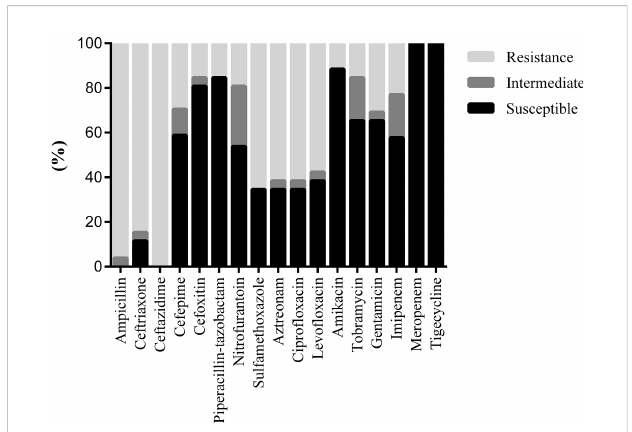
FIGURE 3 Drug sensitivity results of product ESBL bacteria from diabetic foot patient.